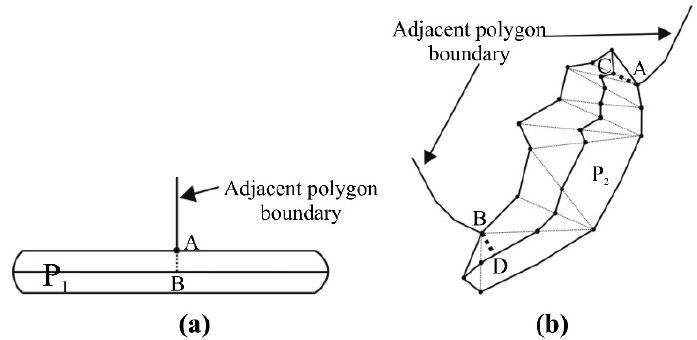
Figure 11. Topological relation constraints: ( a ) perpendicular to the boundary of adjacent polygon and ( b ) at an angle to the boundary of the adjacent polygon.